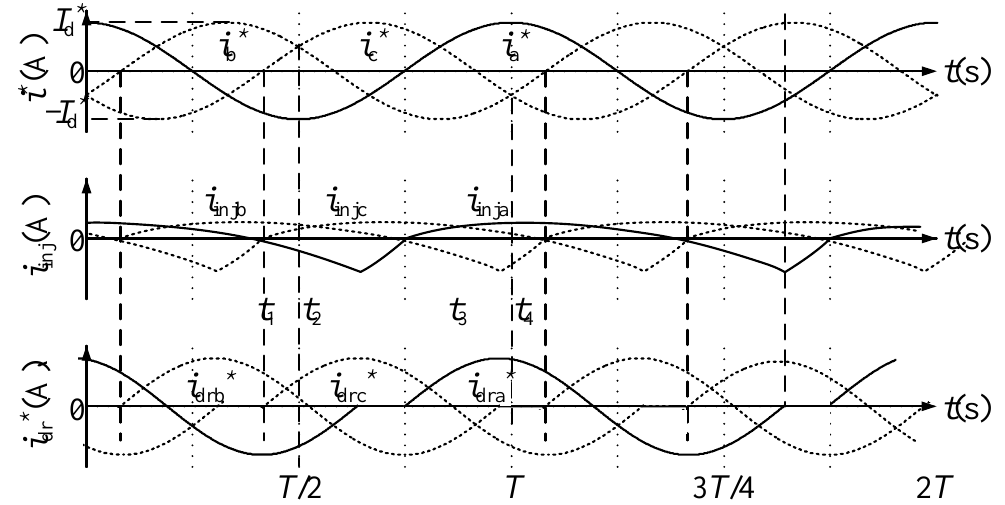
Figure 3. Application of the existing method in the three-phase system.